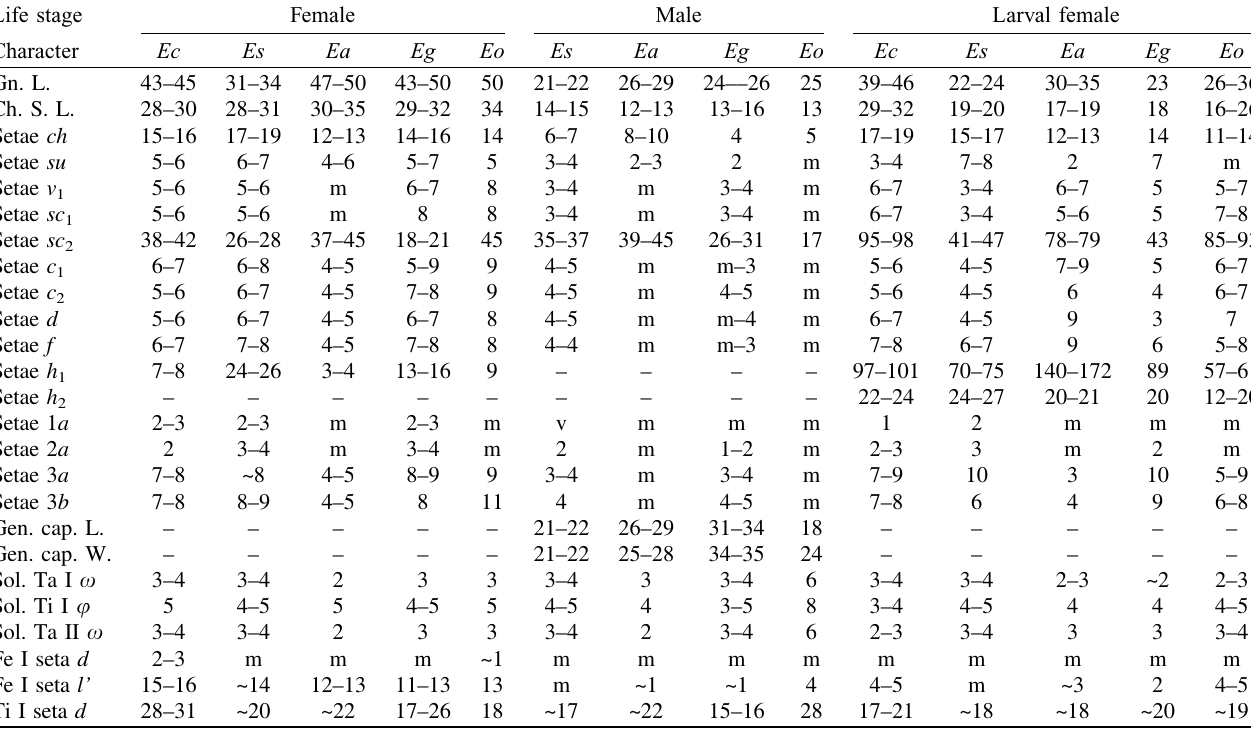
Table 3. Comparison of selected characters (range of measurements if available) of fi ve closely related species of the myzus species group in Eutarsopolipus (male is unknown for E. chlaenii n. sp.): E. chlaenii n. sp. ( Ec ), E. steveni ( Es ) , E. anichtchenkoi ( Ea ), E. gombrooni ( Eg ), and E. oconnori ( Ea ).